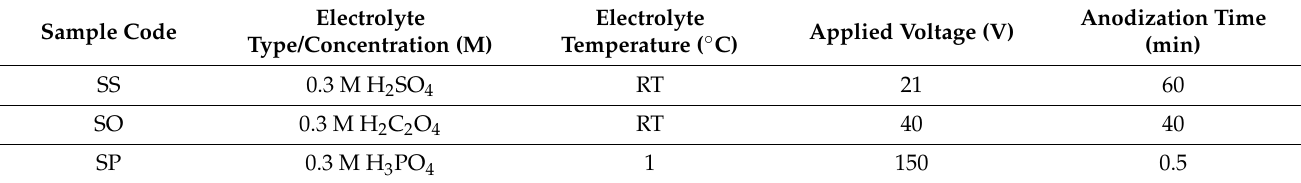
Table 1. The anodization experimental parameters used for the production of NP-AAO with different morphologies. Sample